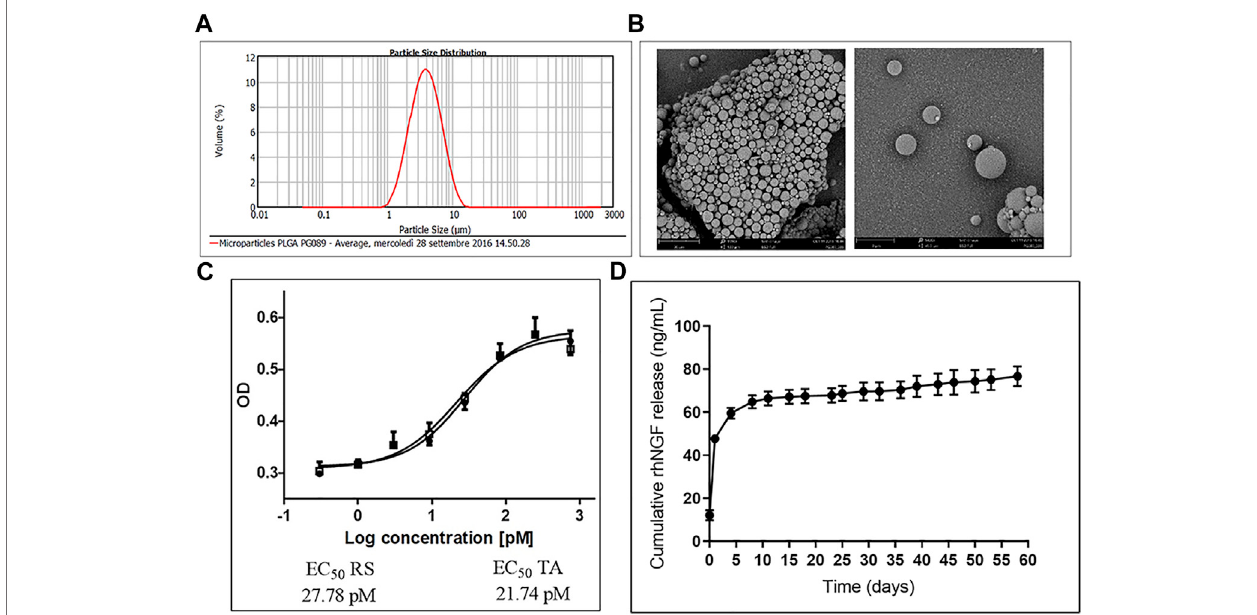
FIGURE 4 | Characterization of rhNGF-MPs. (A) Distribution curve showing particles size of rhNGF-MPs between 2 and 6.8 µm, d (0.5) = 3.6 µm, obtained using Mastersizer2000(Malvern). (B) ExampleimageofdriedmicroparticlesobtainedusingScanningElectronMicroscopy(SEM).Theimageshowsthesmoothandspherical shape of MPs coupled with size measurement. (C) Representative potency assay graph (optical density at 490 vs. Log concentration in PM). The test con fi rms the biologicalactivity preservation ofrhNGFextracted from MPs(TA, empty square) compared toareferencestandard(RS, fi lledcircle). (D) In vitro release kinetic. The graph shows the release pro fi le (cumulative) of rhNGF from MPs from t 0 to 60 days.